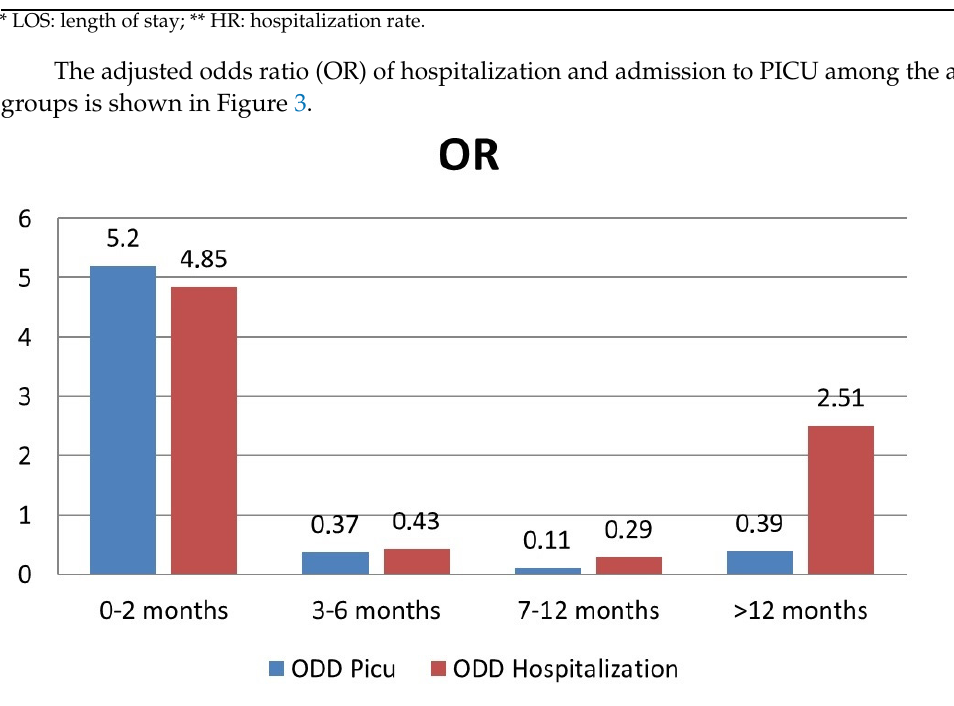
Figure 3. Risk of hospitalization and admission to PICU by age group. Moreover, the adjusted OR of hospitalization among age groups in 2021 compared to 2019 is shown in Figure 4. Figure 4. Risk of hospitalization by age group in 2021 compared to 2019. By analyzing the risk factors for the need for oxygen supplementation, we found a significant relationship with prematurity ( p =0.00001) and age ≤ 2 months old ( p =0.00001). Regarding admissions to the PICU, we found that prematurity ( p =0.0001), age ≤ 2 months ( p =0.0001) and viral coinfections ( p =0.0002) were significantly related. No difference was found in the severity of RSV cases (LOS— p =0.59; admissions to PICU— p =0.76; and mechanical ventilation— p =0.33) between 2019-2020-2021. The number of patients who were transferred to one of the three hospitals with a PICU were, respectively, 3 in 2019 and 70 in 2021 ( p = 0.10); no patient was transferred in 2020. On the contrary, from the main regional Children’s Hospital (Regina Margherita),